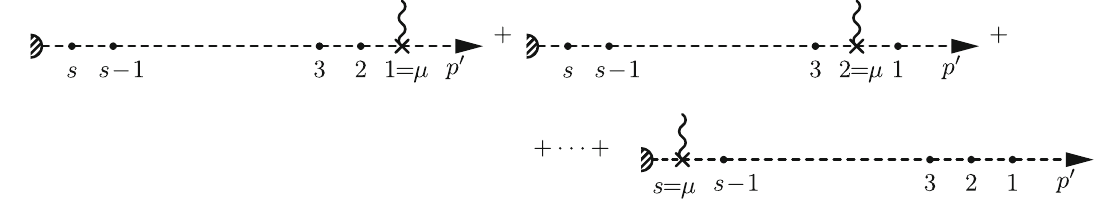
Fig. 3 Set of s diagrams showing all possible insertions of a virtual photon at vertex μ which is one of the already existing s vertices on the p (cid:8) leg of a scalar particle, thus giving rise to a 4-point vertex. Analogous diagrams for fermions do not exist